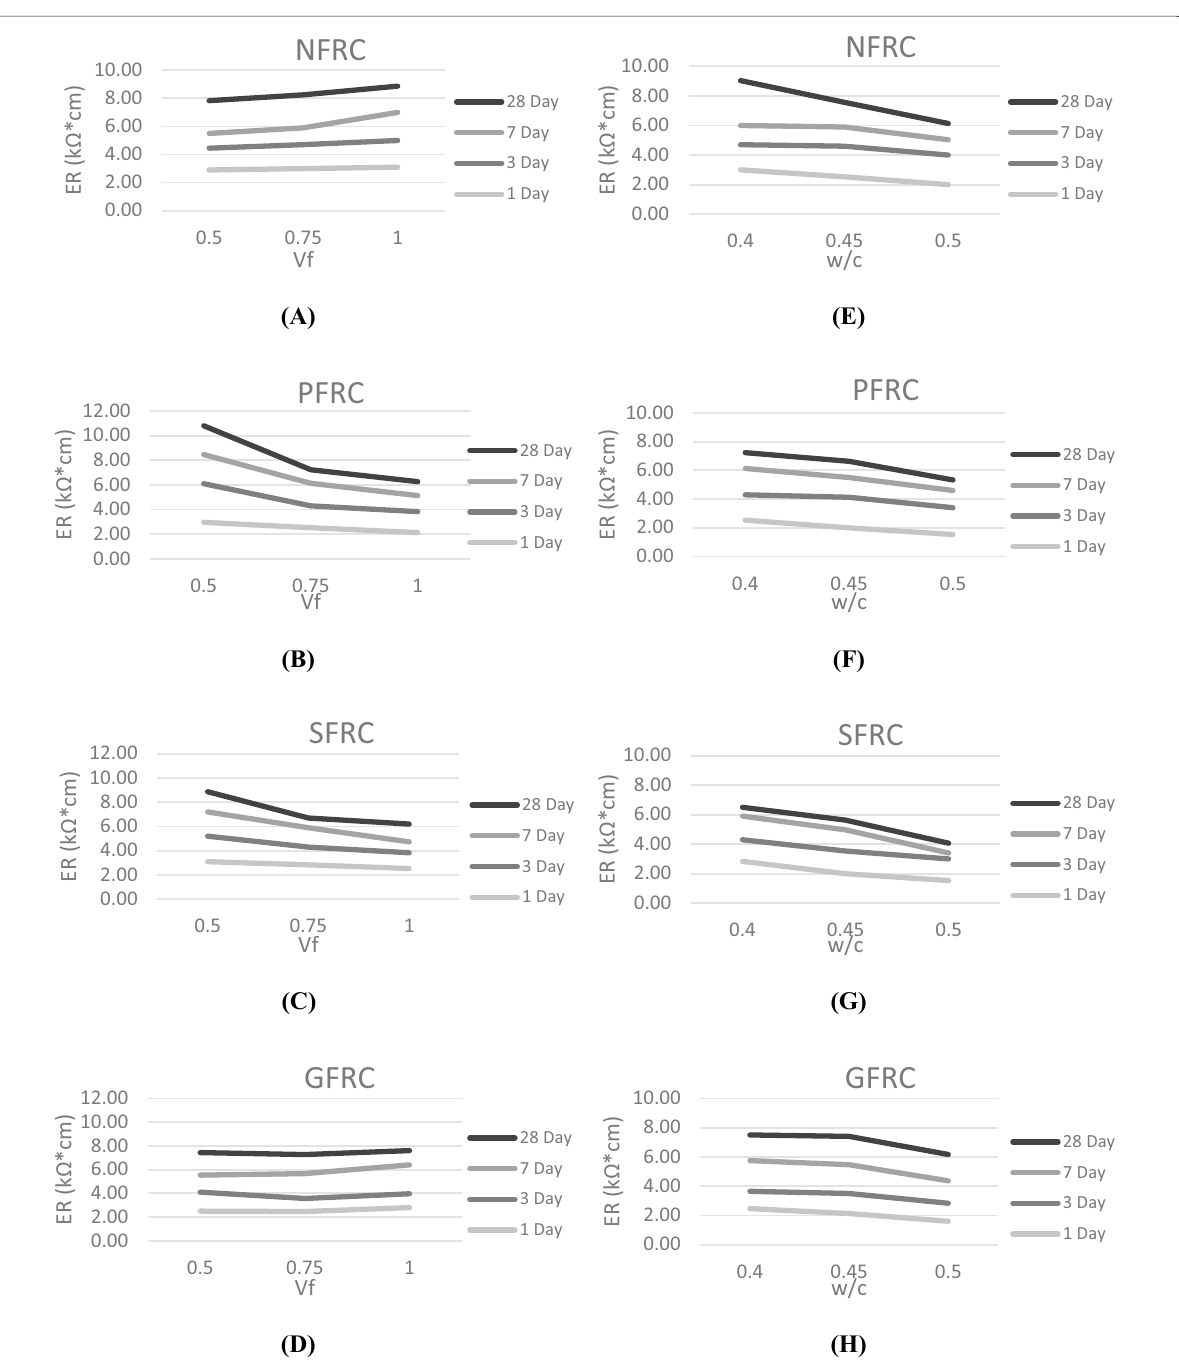
tensile strength of fibers because it is only useful in bridg- ing micro-cracks (Banyhussan et al., 2019). For GFRC with a w / c ratio of 0.4, values for the elastic modulus fluctuated at the early age. However, the varia- tion in all other fiber types remained consistent during